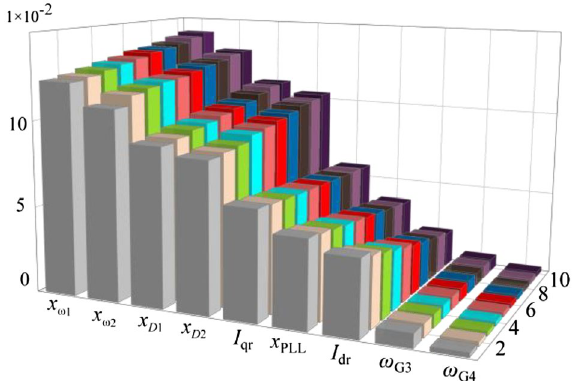
Figure 11. Participation factors for state